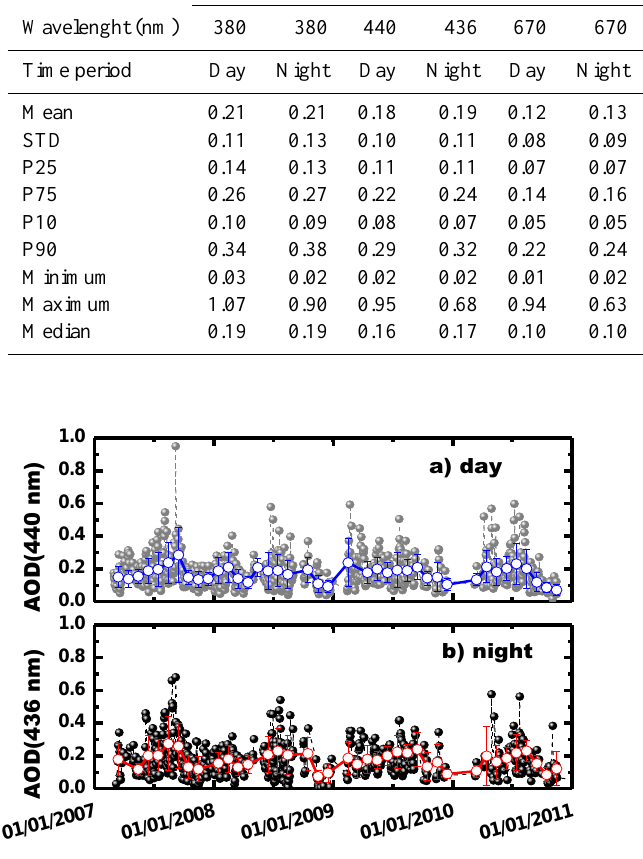
Fig. 1. (a) Temporal evolutions of daytime aerosol optical depth at 440 nm and (b) nighttime aerosol optical depth at 436 nm. Fully circles linked by dash lines corresponds to day/night mean val- Figure 1: Temporal evolutions of daytime aerosol optical depth at 440 nm (a) and nighttime ues, while open circles linked by solid lines represents monthly aerosol optical depth at 436 nm (b). Fully circles linked by dash lines corresponds to day/night day/night values and their standard deviations. All the data were mean values, while open circles linked by solid lines represents monthly day/night values and acquired at Granada from 2007 to 2010. their standard deviations. All the data were acquired at Granada from 2007 to 2010.